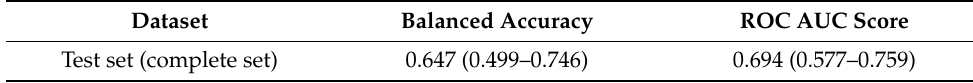
Table 4. Classification performance of complete test set.